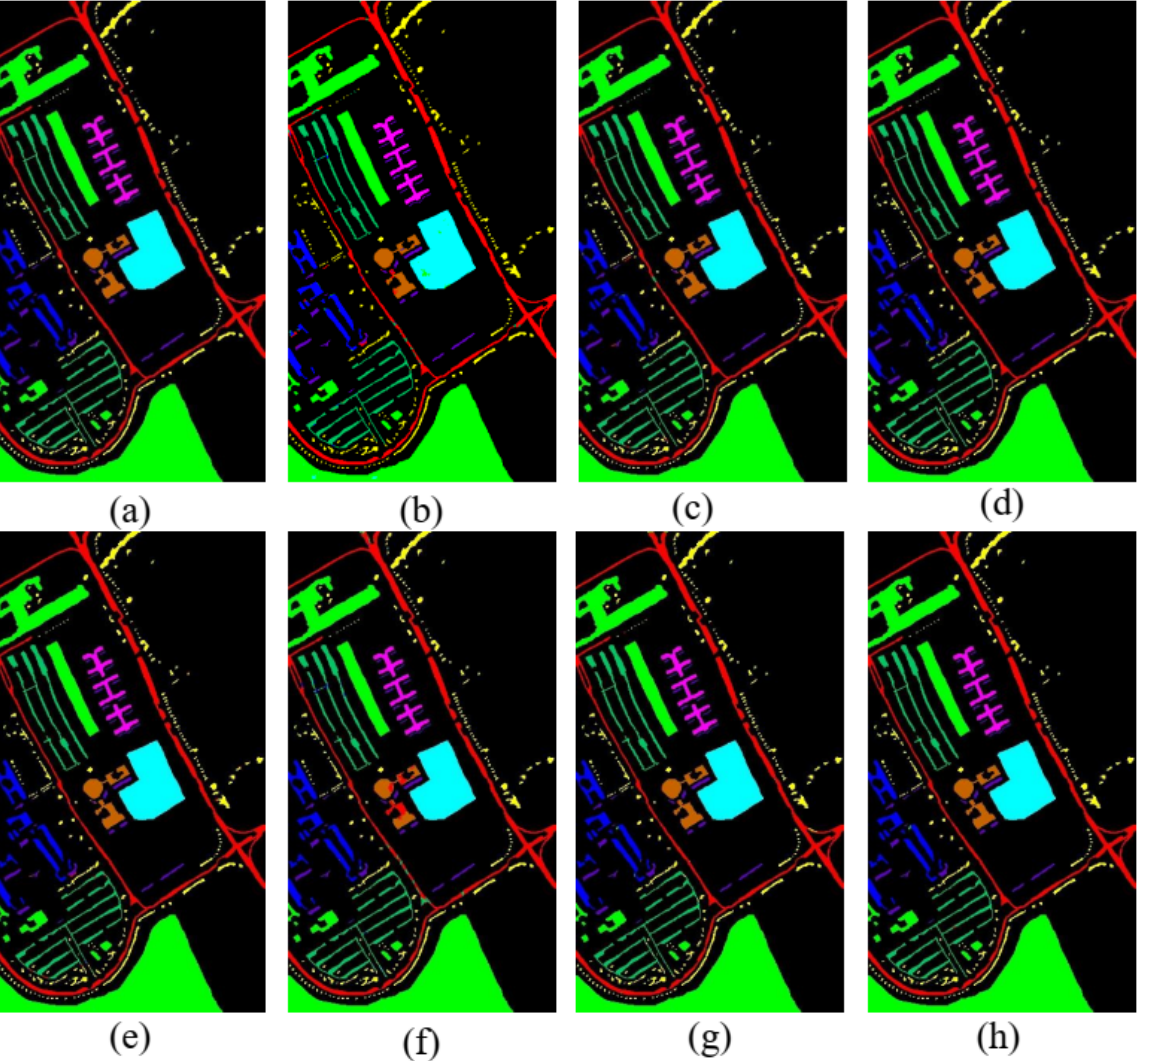
Figure 8. Classification map of various methods for UP ( a ) Ground Truth, ( b ) Resnet, ( c ) 3D-CNN, ( d ) SSRN, ( e ) HybridSN, ( f ) SPRN, ( g ) SSFTT, ( h ) SquconvNet.